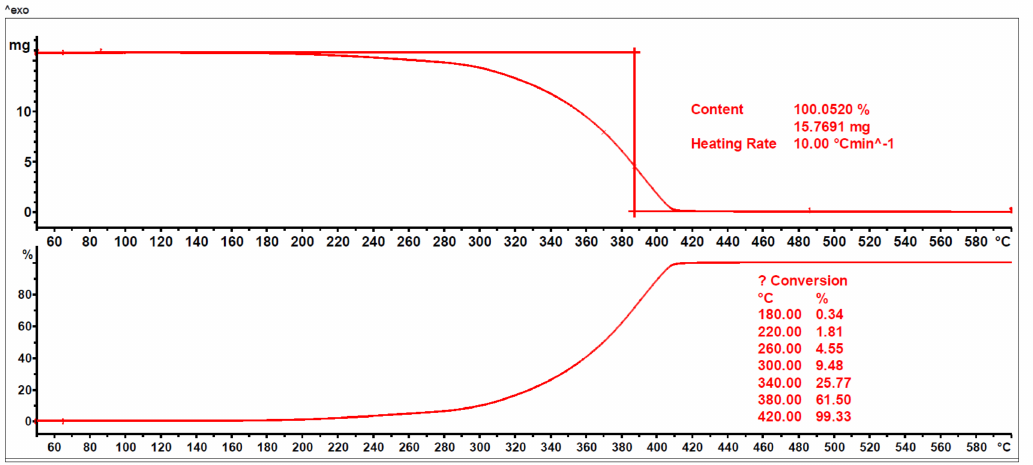
Figure A4. Di ff erential Scanning Calorimetry (DSC) curves of one of the three repetitions of DiTeOHSe synthesized, measuredat2K / minand10K / minwiththreecyclesforeachheatingrate. Thecrystallization peaks are found on the upper part of the graph, while the melting ones are found on the lower part. Each text color matches the corresponding curve. For each transition, the onset, peak, and endset transition temperatures are indicated, alongside the normalized integral (corresponding to ∆ H ) and the heating rate. The phase change temperatures and enthalpies are in accordance with what is reported by Aydin et al. [24] ( T c = 49.78 ◦ C, T m = 50.78, ∆ H = 202.17 J / g). No side peaks from residual impurities are visible, thus confirming the high purity achieved.